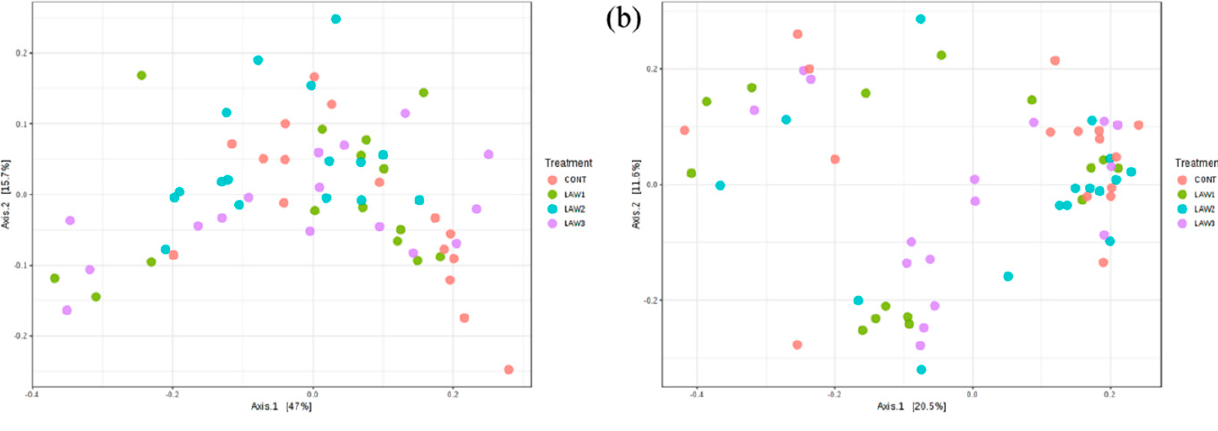
Figure 2. Beta diversity analysis of gut microbiota in piglets orally vaccinated with Lawsonia intracellularis vaccine . Princi- pal coordinates analysis (PCoA) plots of pig gut microbiota at week 0 ( a , b ) (ANOSIM: R = 0.01, p < 0.175) and at week 6 ( c , d ) (ANOSIM: R = 0.11, p < 0.001) based on the weighted ( a , c ) and unweighted ( b , d ) UniFrac distances. Dots represent the gut microbiota from each sample and are color coded according to the treatment group (CONT, LAW1, LAW2, and LAW3) as shown in the legend. 3.5. Microbiome Composition of Pigs Associated with Lawsonia intracellularis Vaccination at the Phylum Level The intestinal microbiome of pigs vaccinated with different doses of oral vaccine against L . intracellularis were determined. The relative abundance of different bacterial taxa at the phylum level among the four groups (CONT, LAW1, LAW2, and LAW3) be- tween week 0 and week 6 is shown in Figure 3. The most common phyla in all the samples at both week 0 and week 6 were Firmicutes and Bacteroidetes. At week 0, Firmicutes and Bacteroidetes were the most predominant bacteria, ranging from 82.96 to 94.66% with the highest abundance from the LAW2 group accounting for 94.66% followed by the LAW3 (87.08%), LAW1 (85.91%) and CONT (82.96%) groups. In addition, the relative abundance of Proteobacteria ranged from 0.71 to 11.94% with the highest abundance from the CONT group (11.94%) followed by LAW1 (10.04%), LAW3 (9.52%) and LAW2 (0.71%). At week 6, Firmicutes and Bacteroidetes were also the most predominant phyla in all the samples, which collectively ranged from 93.13 to 96.25% of the total bacteria with the CONT group having the highest combined relative abundance of 96.25% followed by LAW1 (95.13%), LAW2 (94.48%) and LAW3 (93.13%). Moreover, the relative abundance of Proteobacteria ranged from 0.27 to 2.19% of all the bacteria with the lowest and highest in the CONT and LAW3 group, respectively. These findings were similar to previous studies in swine gut microbiota, suggesting that phylum Firmicutes and Bacteroidetes are the major phyla, re- gardless of L . intracellularis vaccine treatment.